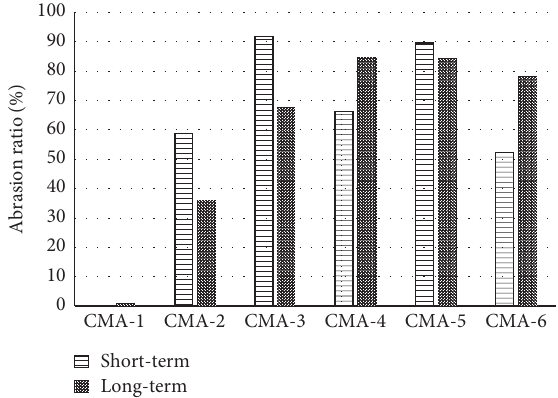
Figure 9: Abrasion ratio for short- and long-term performance.